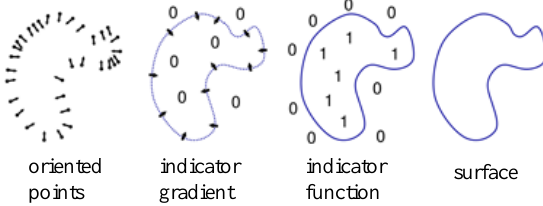
Figure 3. Extracting surface using poisson